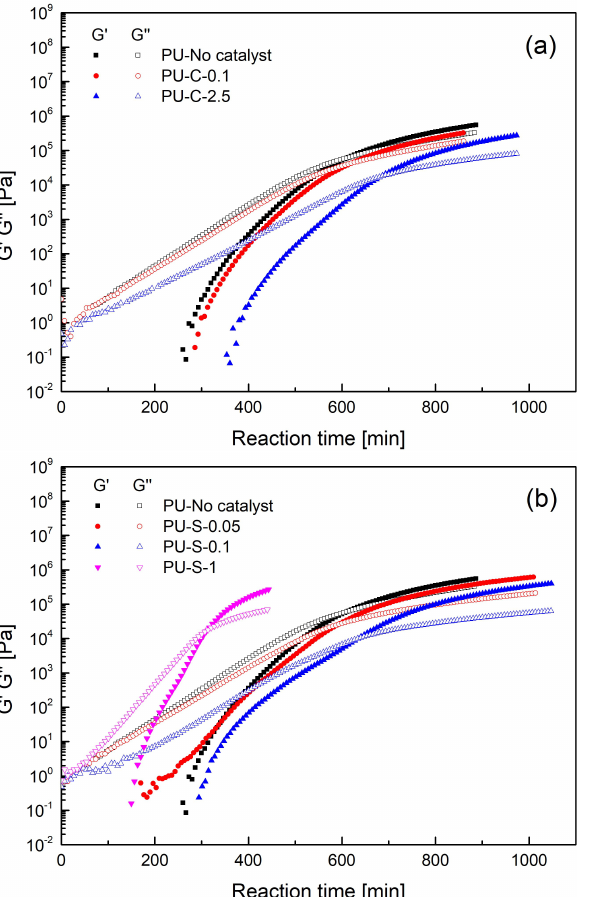
Figure 6: Time sweep tests for polyurethane reactions with different inhibitors Benzoyl-Chloride (a), and para-Toluene-Sulfonic Acid (b)